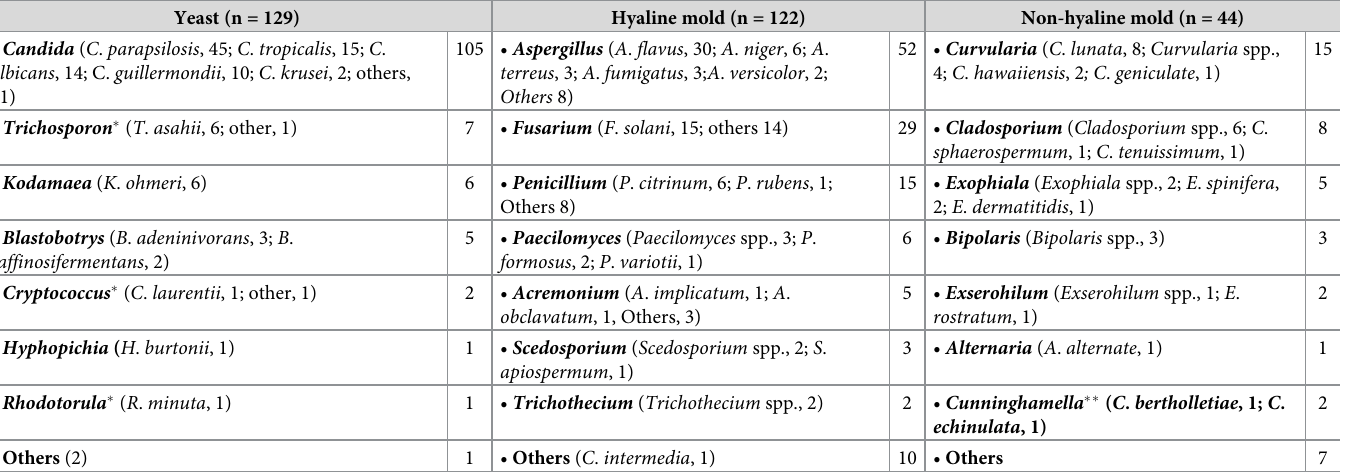
Table 1. Spectrum of fungal organisms isolated from fungal peritonitis